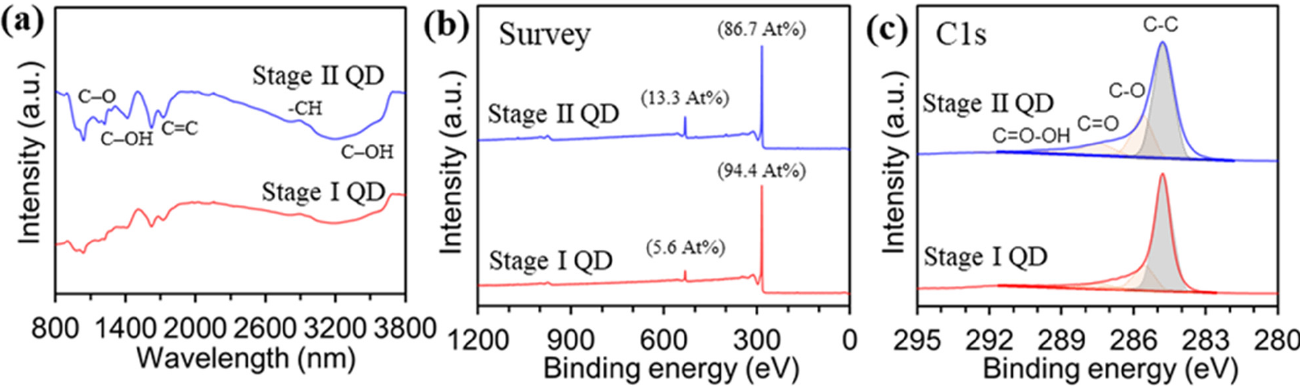
Figure 3. Characterizations for the stage I and stage II GQDs. ( a ), FT-IR spectra. Chemical composi- tions for carbon and oxygen measured by XPS ( b ), Survey spectra. ( c ), deconvoluted C1s peaks